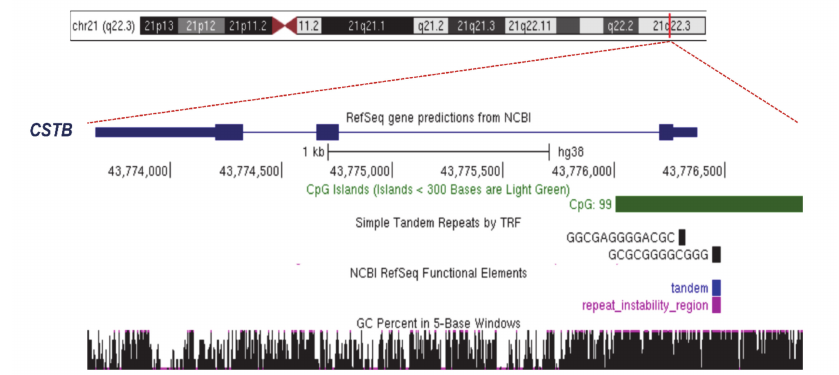
Figure 2. The physical map of CSTB locus reveals a large CpG island. A region 3321-bp long is shown. chr21:43,773,550-43,776,870 UCSC Genome Browser on Human Dec. 2013 (GRCh38 / hg38)